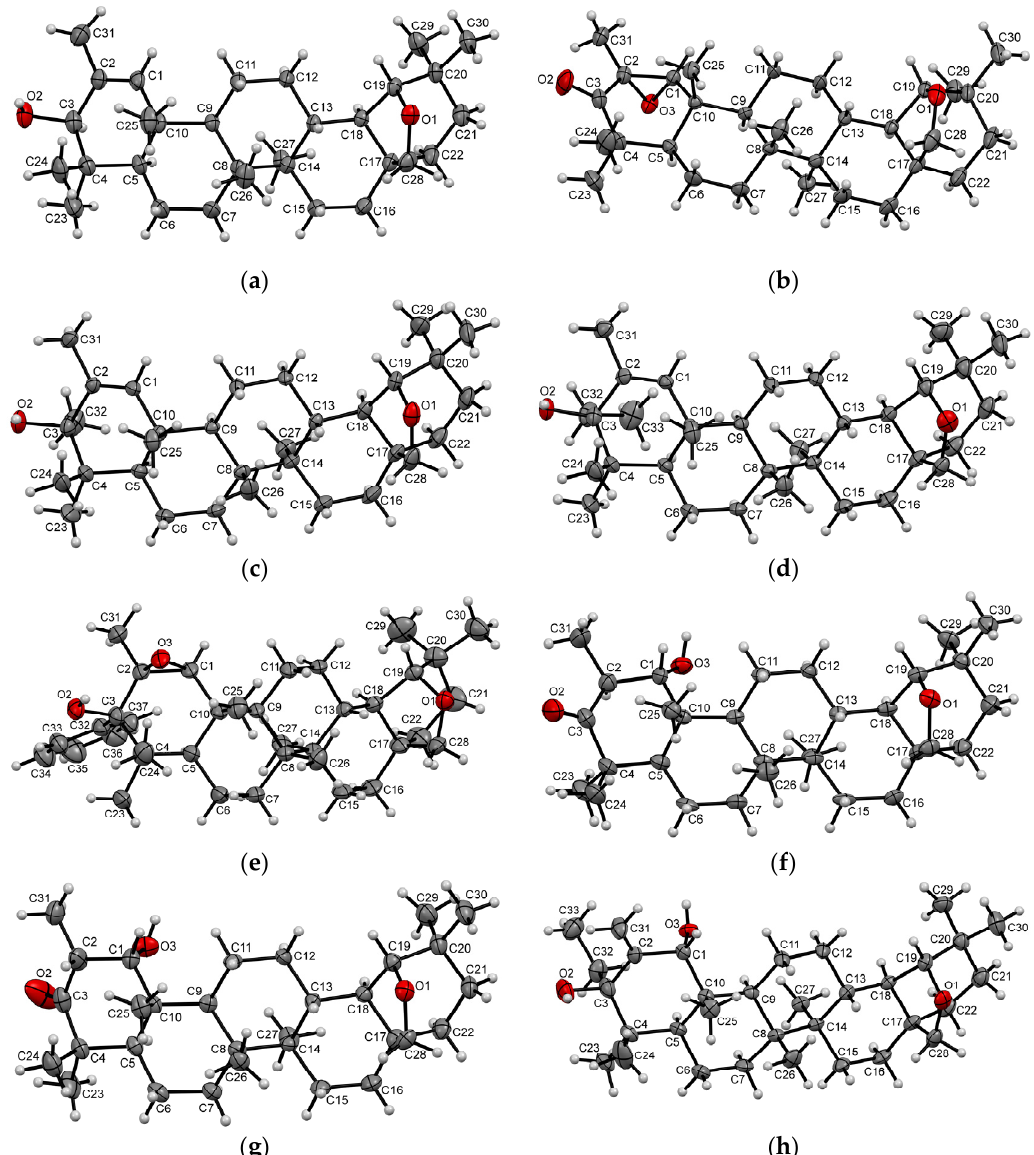
Figure 1. Molecular structures of compounds 3 ( a ), 4a ( b ), 7 ( c ), 8 ( d ), 12 ( e ), 13 ( f ), 14 ( g ), 15 ( h ) with atoms represented as thermal vibration ellipsoids, with 50%